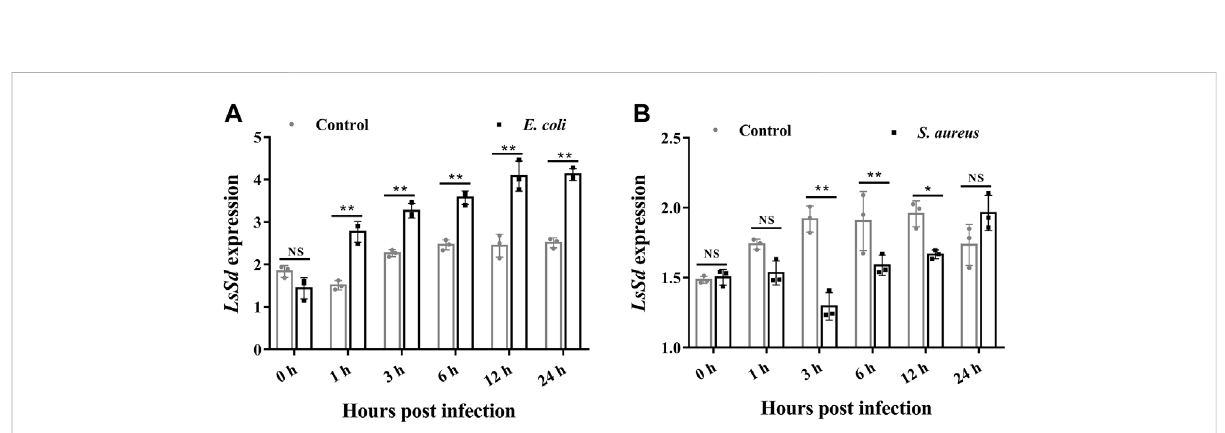
FIGURE 3 The mRNA transcript levels of LsSd in whole larvae (30-day-old) after microbial challenge. After injections of E. coli (A) and S. aureus (B) , the mRNA transcript levels of LsSd were analyzed by RT-qPCR. Error bars indicate the SEM of three independent biological replications. Signi fi cant differences between the microbial challenge group and control group were determined using Student ’ s t -test (* p < 0.05, ** p <